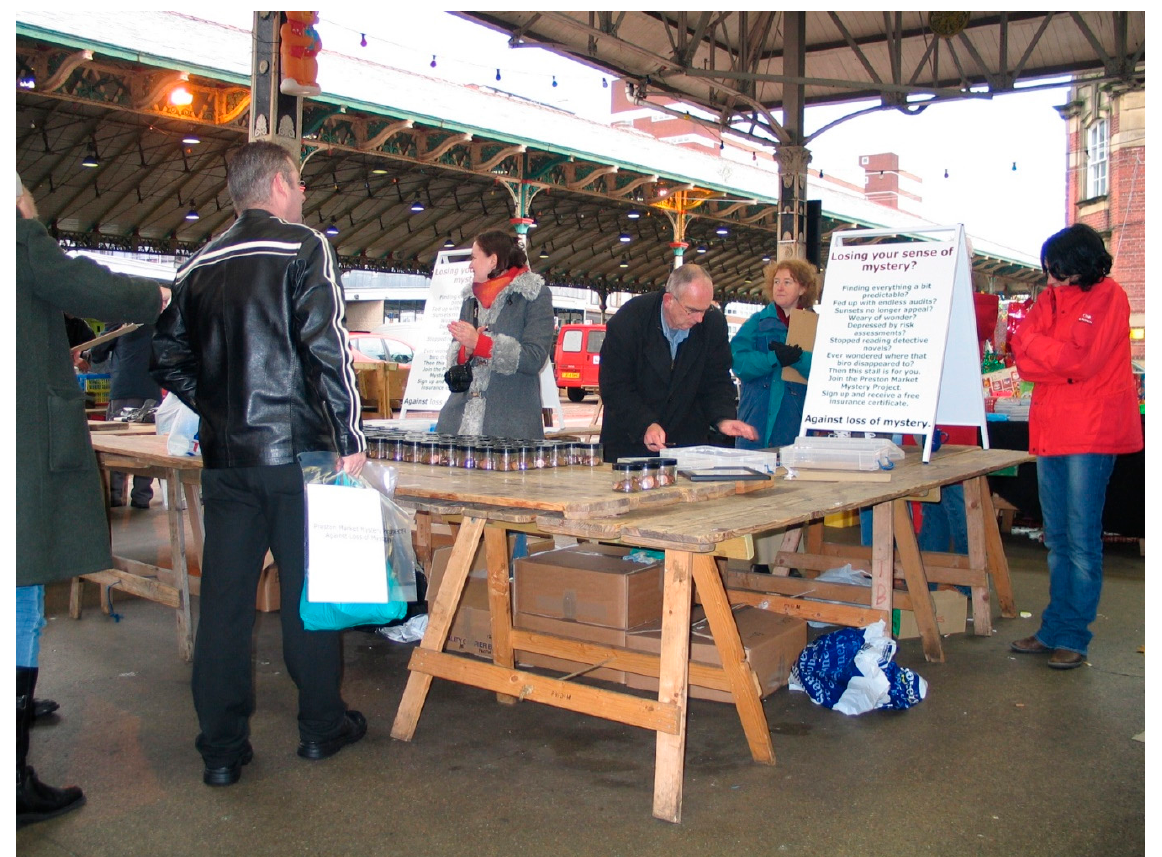
Figure 2. The Preston Market Mystery Project: The Insurance Stall, November 2006 (Newling 2008) (Courtesy of the artist).